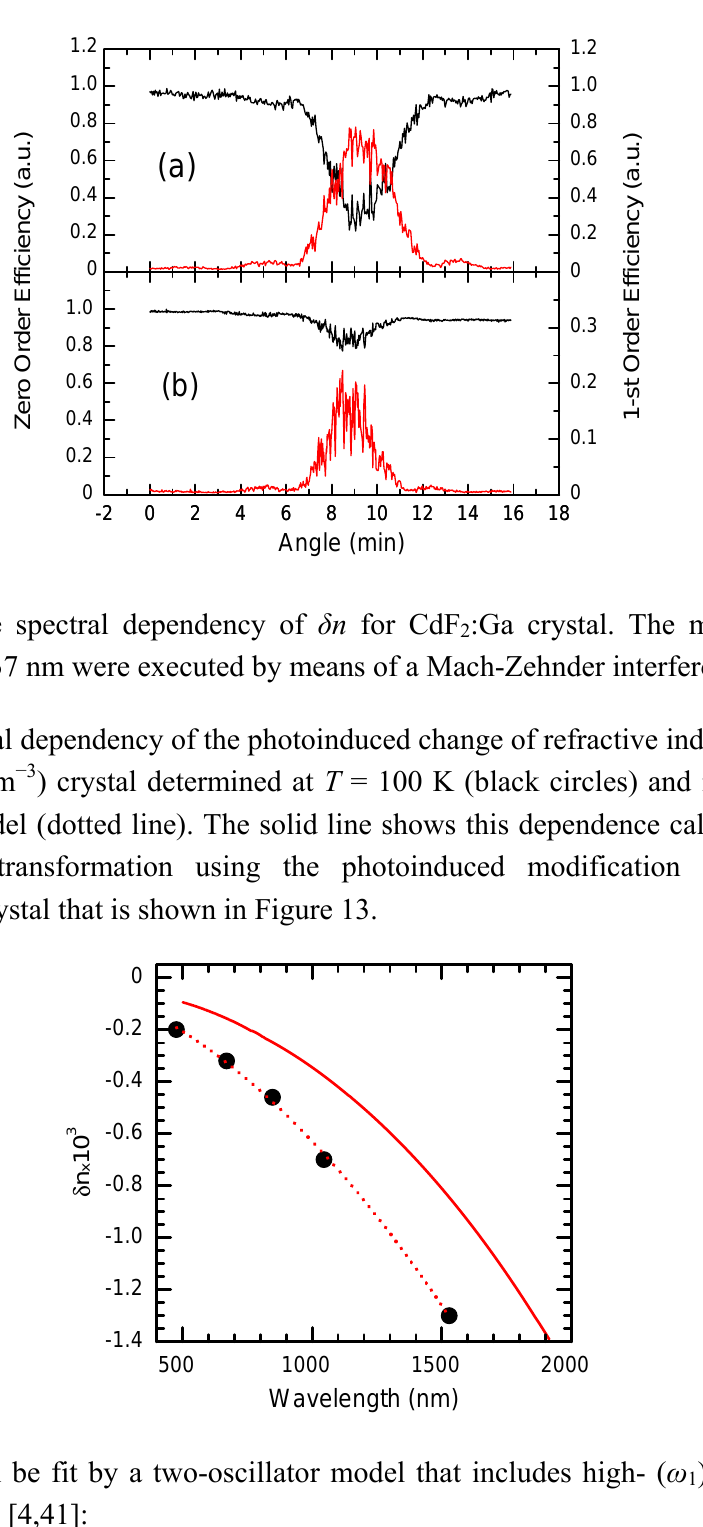
Figure 11. Angular dependencies of the zero-(black lines) and first-order (red lines) diffraction responses of CdF :Ga,Y crystal with hologram at readout by ( a ) 532 nm and 2 ( b ) 660 nm radiation.